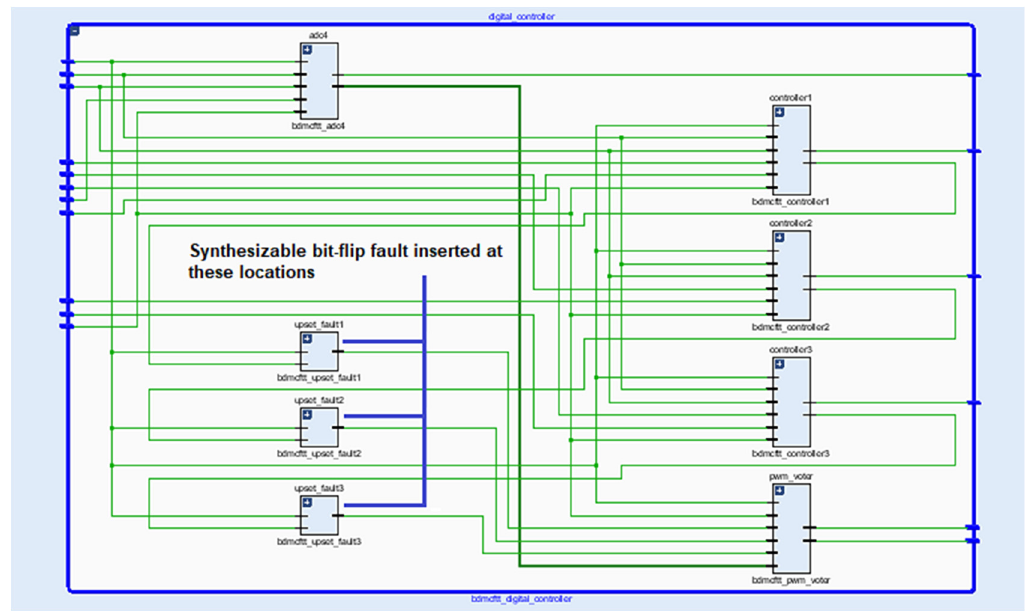
Figure 13. Schematic after synthesis showing the location of the insertion of bit-flip synthesizable fault models.